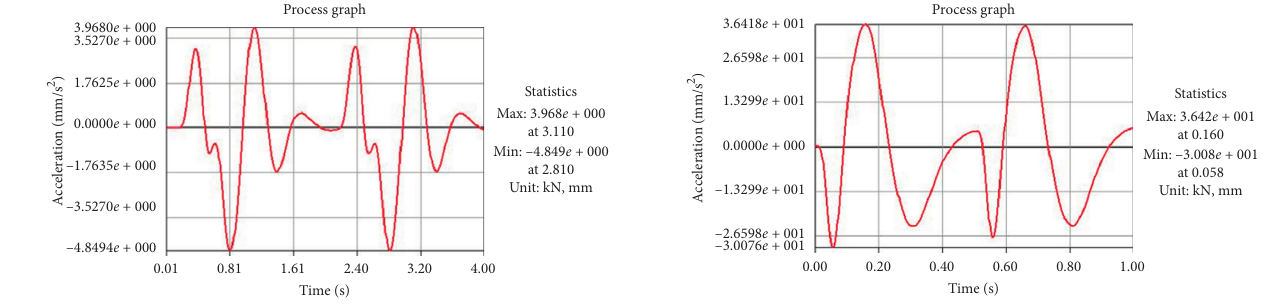
Figure 24: Ground acceleration at the pit bottom.